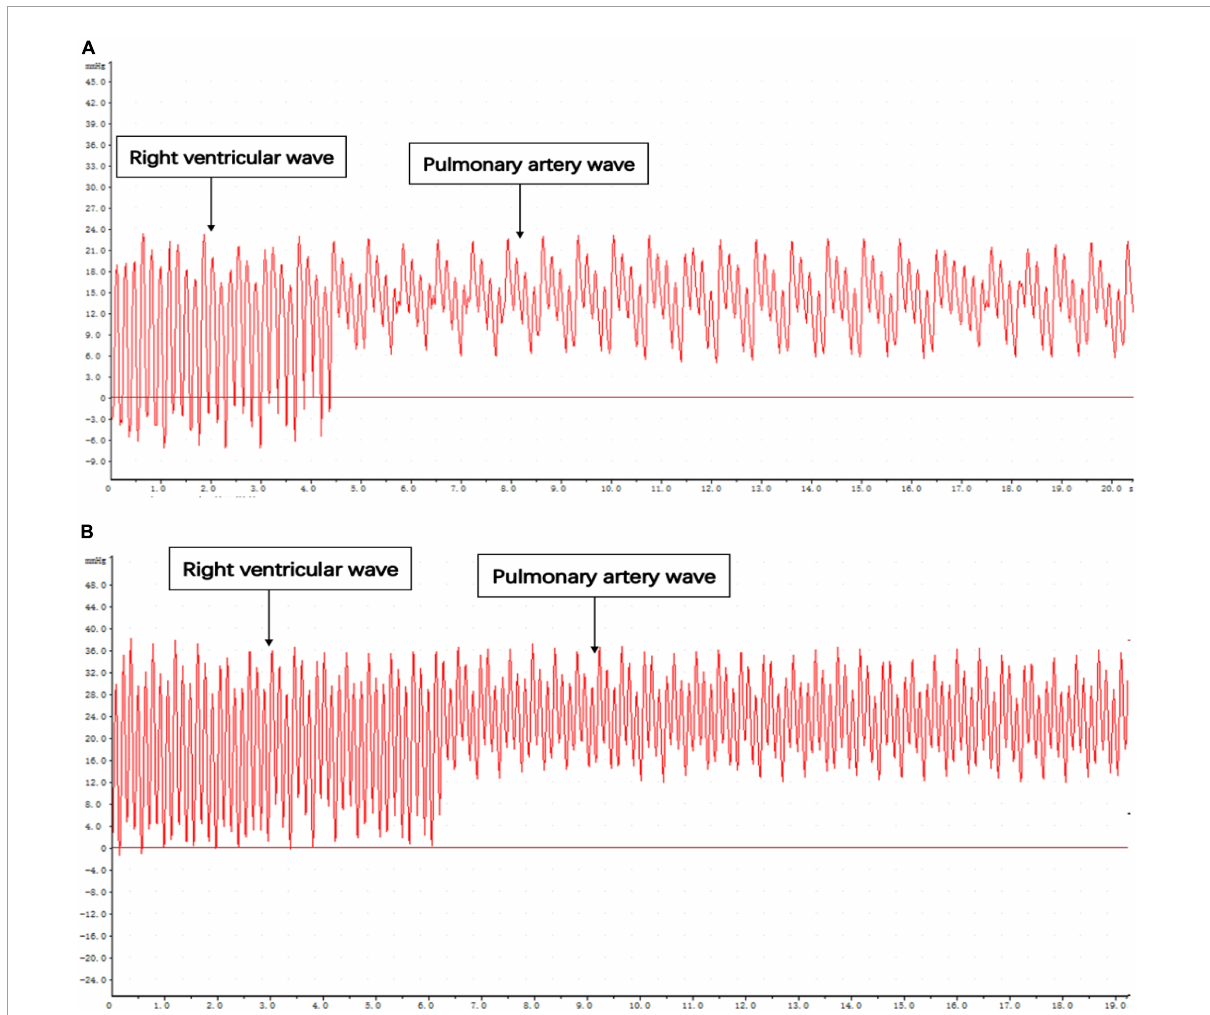
FIGURE5 Pressure curve of catheter entering right ventricular outflow tract and pulmonary artery. (A) Control. (B) MCT